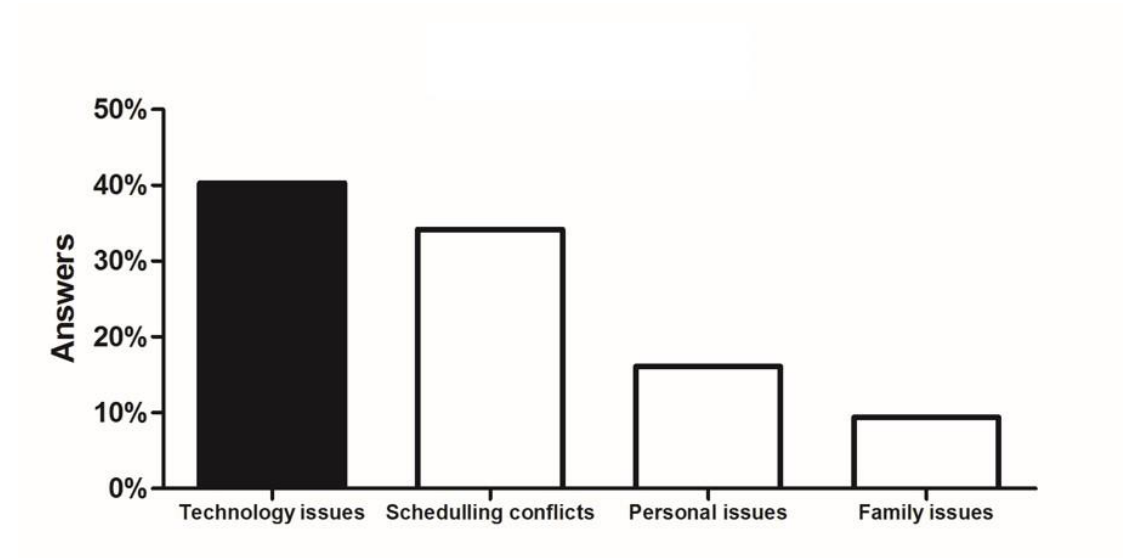
Figure 3. Teachers’ (n=149) self-reported reasons for abandoning online courses. Internal (black bars) and external causes (white bars) are defined based on Park & Choi (2009) theoretical framework. Adapted from “Factors influencing adult learners’ decision to drop out or persist in online learning,” by J. Park and